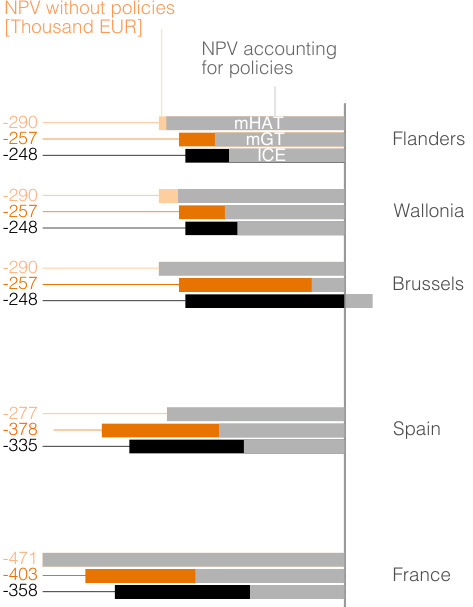
Figure 13. mHAT does not receive any subsidies in Brussels, Spain or France. The effect of policies is visible for the rest of the cases as the difference between the grey bars (representing the NPV with subsidies) and the coloured bars (NPV without